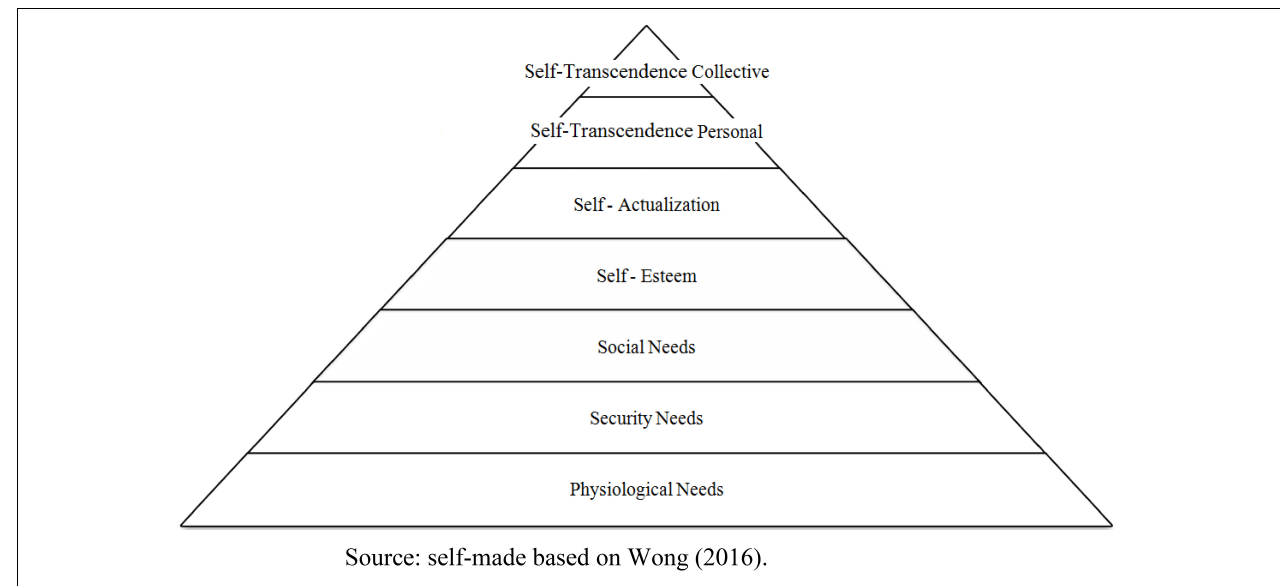
FIGURE 1 | Maslow’s modified extended hierarchy of needs including spiritual needs. The self-transcendence level is divided by personal and